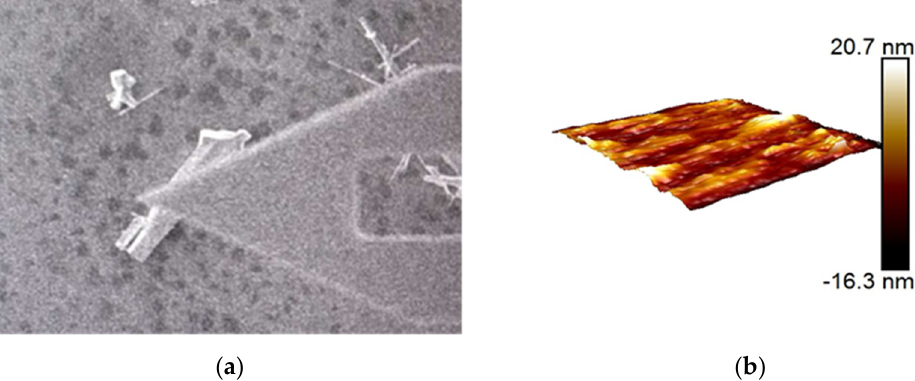
Figure 7. Morphology and mechanical properties of ZnO nanorods in the range of 2 μ m × 2 μ m. ( a ) AFM is scanning a single ZnO nanorod. ( b ) Morphology of an observed nanorod.